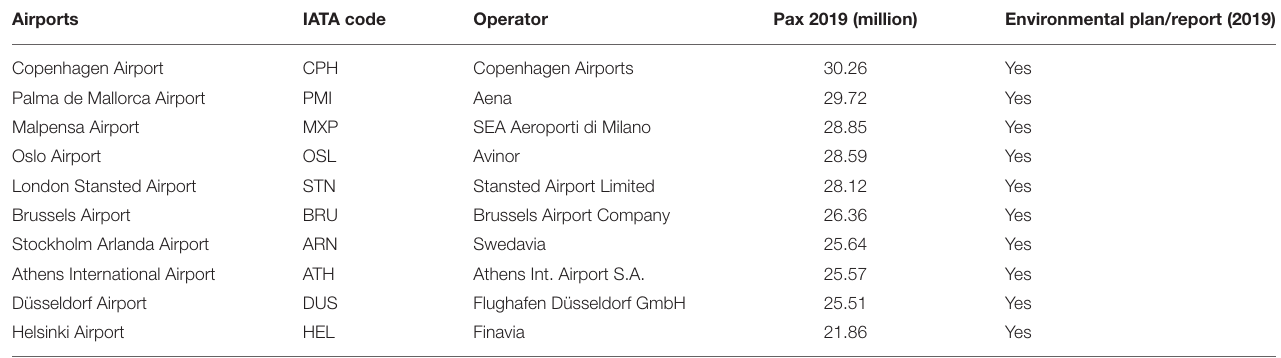
TABLE 3 | European Airports’ key facts.